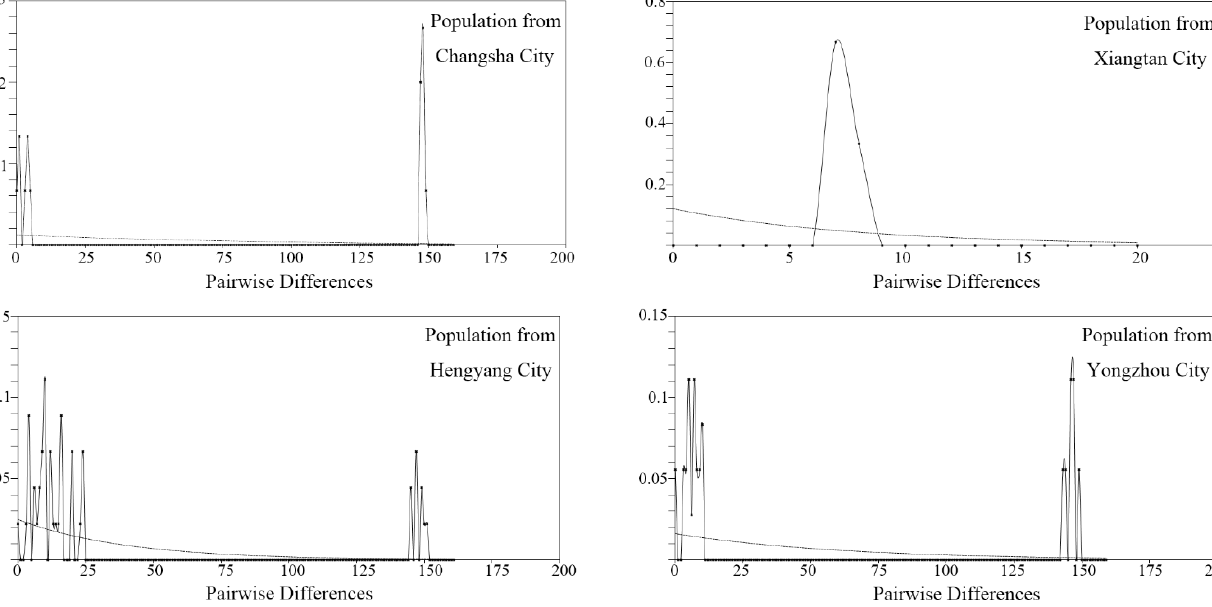
Figure 5. Maps of the mismatch distribution of population from seven cities in Hunan Province, based on mitochondrial genes COI + COII + 12S + 16S + ND1 . The abscissa represents the number of pairwise distances. The ordinate represents the number of observations. The lines represent the ex- pected (dashed) and observed (smoothed) frequencies of pairwise differences under sudden lineage expansion.